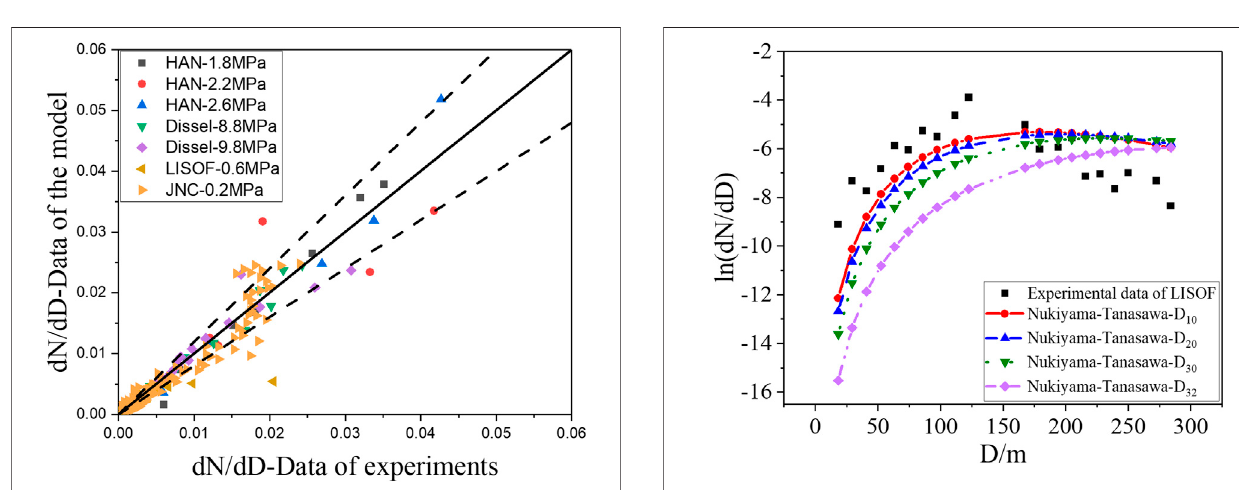
FIGURE 10 | Comparison of Nukiyama-Tanasawa model at different mean diameters with LISOF experimental